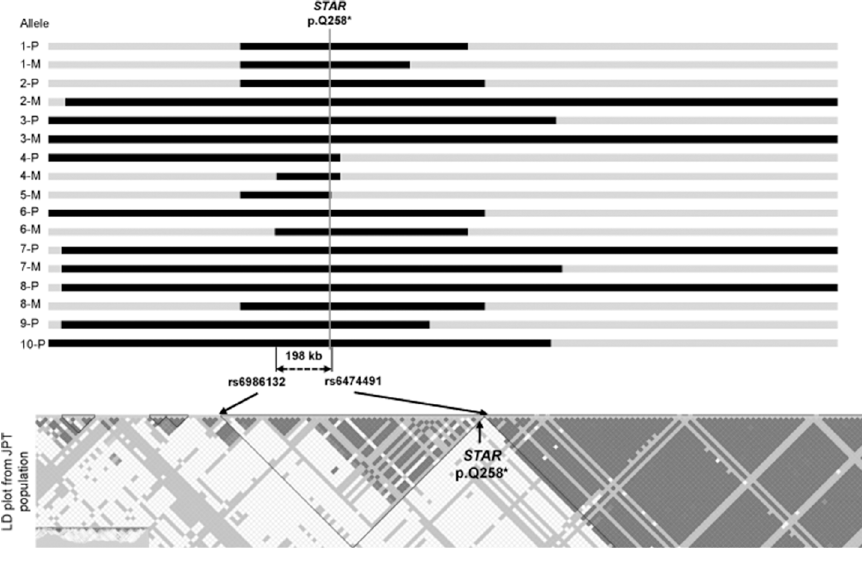
Figure 2. Haplotypes of the alleles with p.Q258* mutation in the STAR gene. The gray vertical line illustrates the location of the mutation, and the horizontal black bars indicate regions of the shared haplotype in each allele. The minimum size of the shared haplotype is approximately 198 kb. P, paternal allele; M, maternal